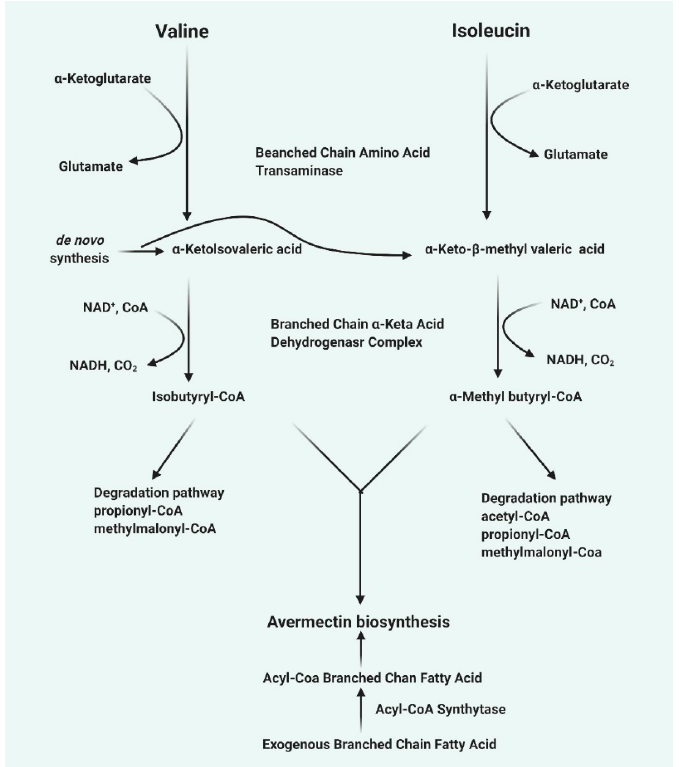
Figure 1. The biosynthesis of some classes of avermectins.